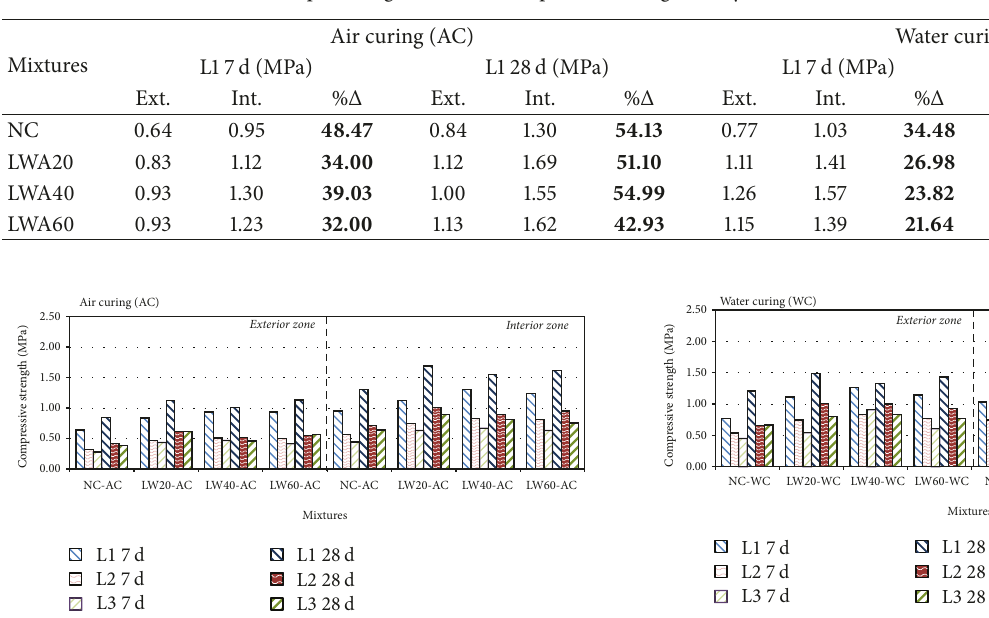
Figure 12: Normal-bonded NWCA (left) and well-bonded AAC-LWA (right) with cement paste on interfacial transition zone (ITZ). Table 5: Differential percentage of minute compressive strength in layer 1 (L1) between exterior and interior zone.